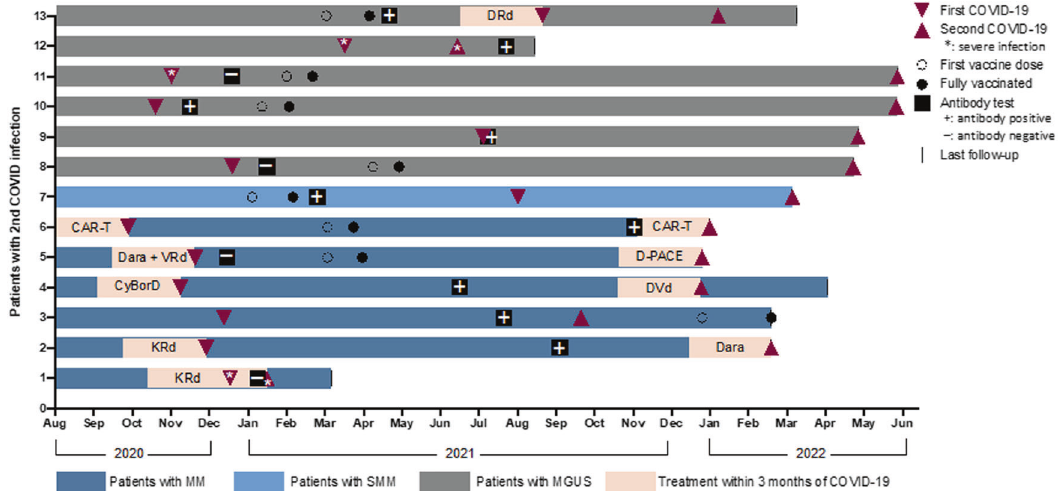
Fig. 1 Second COVID-19 infections. The fi gure demonstrates a timeline of second COVID-19 infection in patients with monoclonal gammopathy in relation to antibody status and treatment